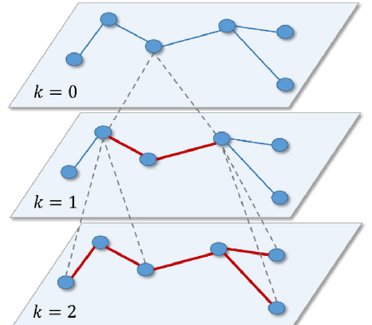
Figure 5. Receptive field of the two stacked graph convolutional layers. ISPRS Int. J. Geo-Inf. 2021 , 10 , x FOR PEER REVIEW